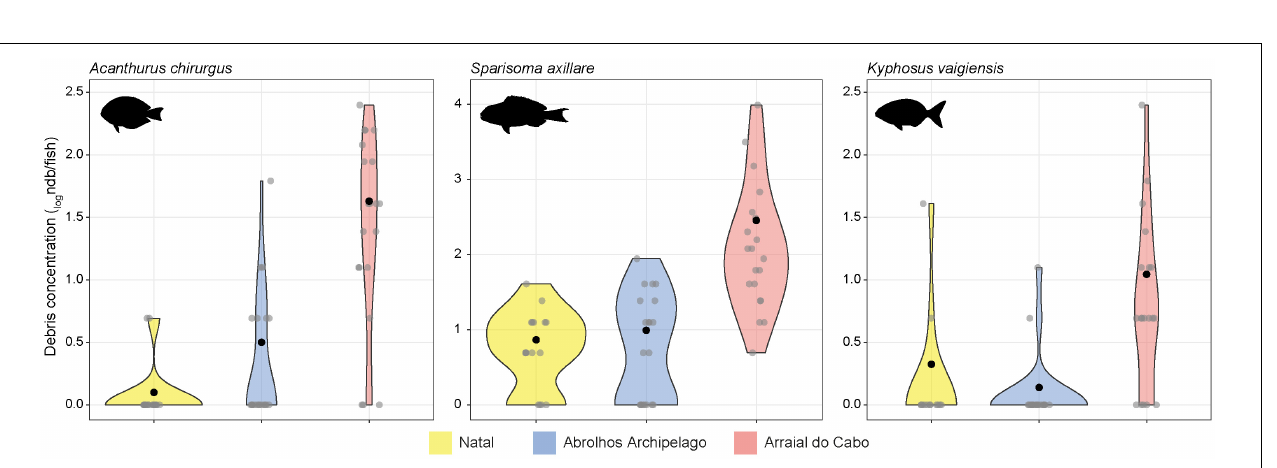
FIGURE 1 | Comparison of debris concentration (debris per fish – ndb/fish) in the gut contents among locations for the three study species. Gray dots are each analyzed individual, and black dots are the mean for each species in each location. Values are in logarithmic scale for better visualization.